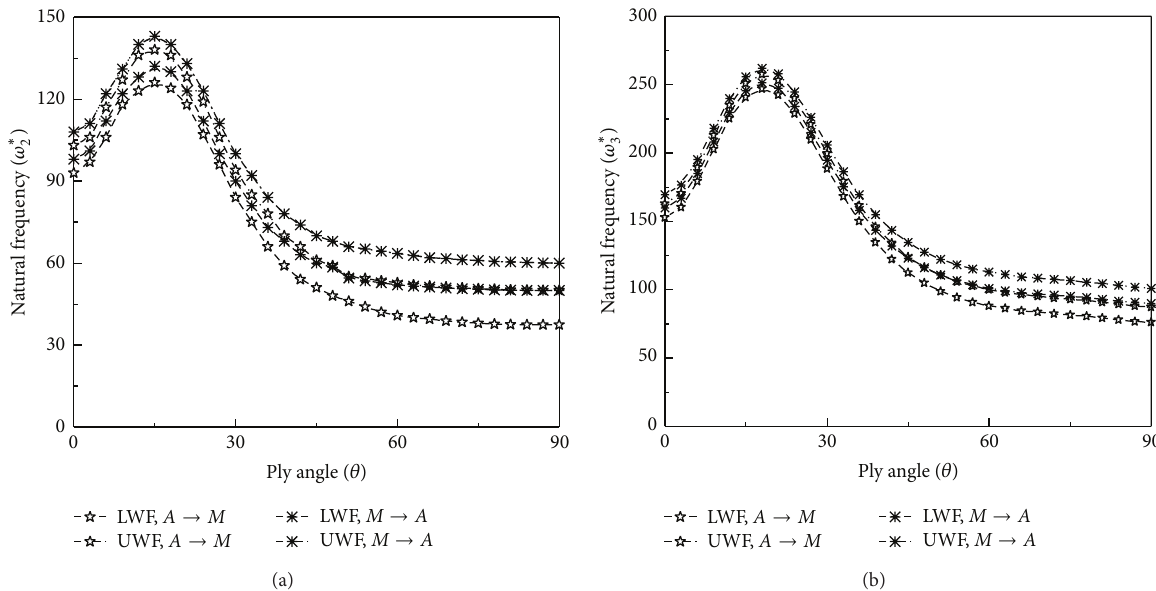
Figure 10: The first three natural frequencies versus ply angle during heating and cooling processes at 50 ∘ C ( 𝑉 𝑠 = 0.12 ; Ω ∗ = 5 rad/s; = 0.067 ). 𝜀 0